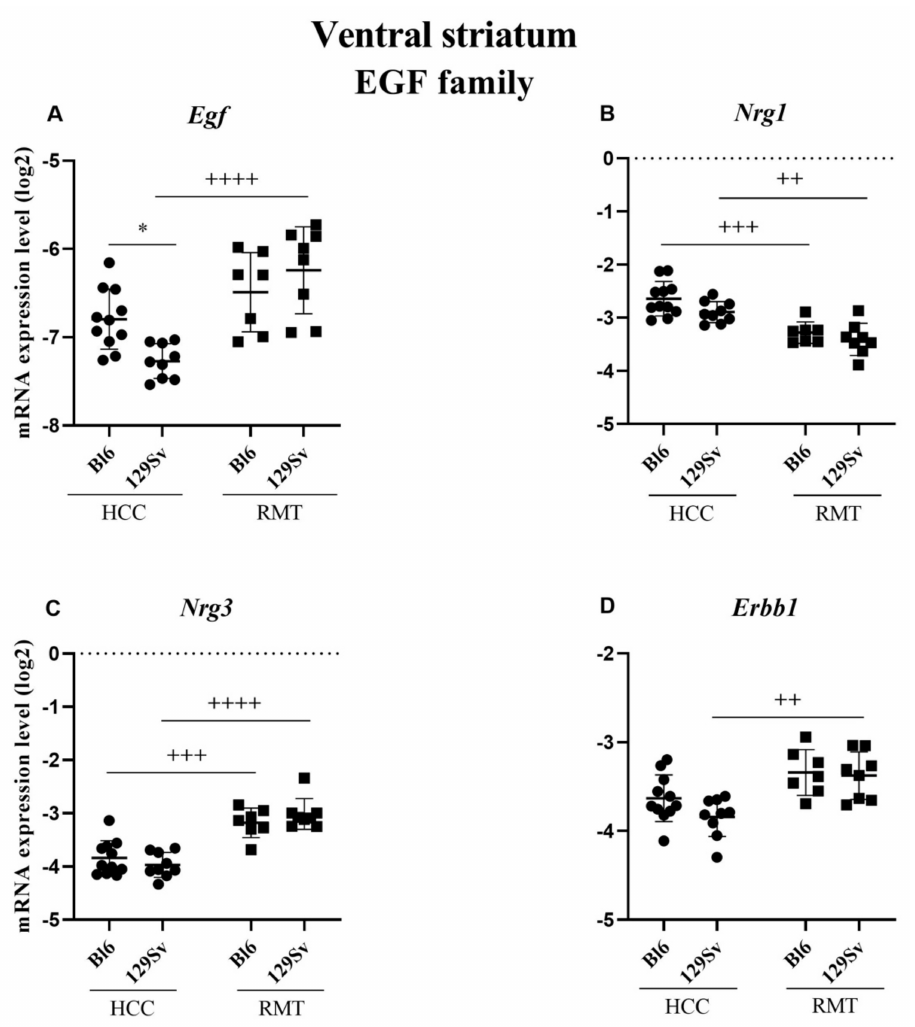
Figure 12. Egf family gene expression in ventral striatum of Bl6 and 129Sv mice. Two-way ANOVA was applied to demonstrate differences between the strains and environments. Substantial statistically significant gene expressions for ( A ) Egf —epidermal growth factor, ( B ) Nrg1 —neuregulin 1, ( C ) Nrg3 —neuregulin 3 and ( D ) Erbb1 —epidermal growth factor receptor. Bonferroni post hoc test: * p ≤ 0.05 compared to respective 129Sv mice, ++ p ≤ 0.01, +++ p ≤ 0.001 and ++++ p ≤ 0.0001 in strain specific comparison. Data are expressed as mean values ± SD. Number of animals in each group varied from 7 to